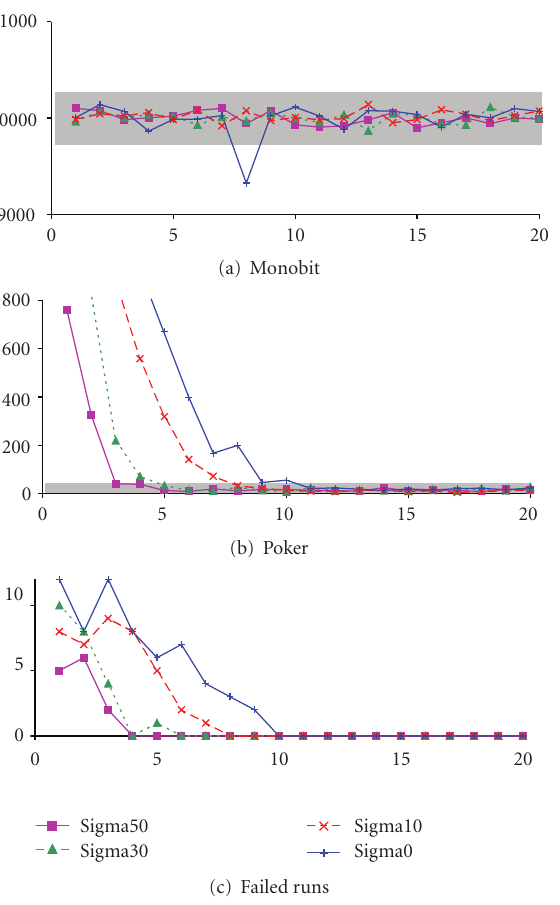
Figure 9: Results of the FIPS 140-2 tests of the Wold’s TRNG architecture simulations with internal reference clock and varying size of injected Gaussian jitter.